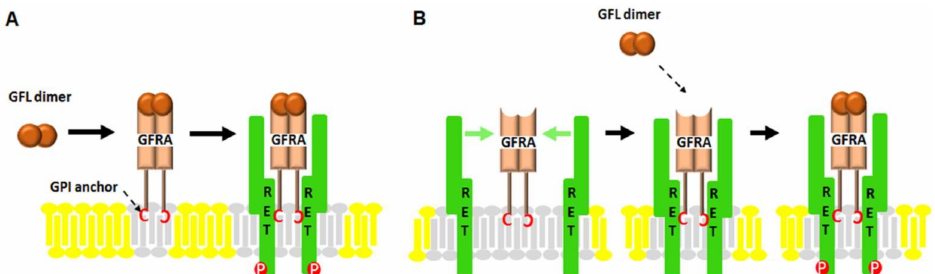
Figure 2. Two hypothetical modes of RET interaction/stimulation by GFL/GFRA. The extracellular domain of RET tyrosine kinase binds with GFL/GFRA which is linked to the plasma membrane via a glycosyl phosphatidylinositol (GPI) anchor. The interaction of RET with GFL/GFRA leads to the phosphorylation of tyrosine residues located in intracellular domain of RET and activates downstream signaling pathways. ( A ) GFL dimer binds to the GPI-anchored GFRA in lipid rafts and recruits RET;